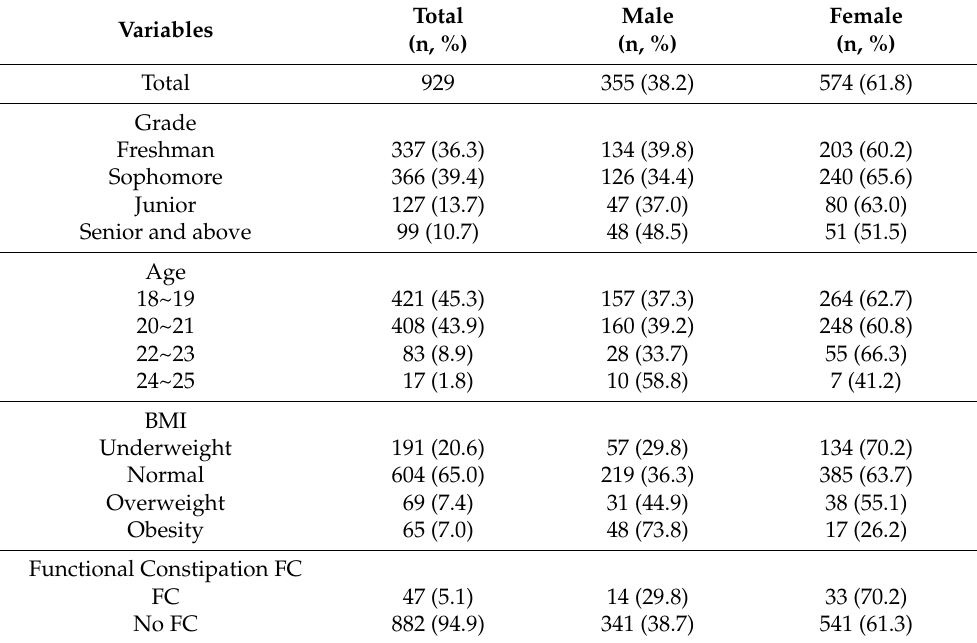
Table 1. Different demographic characteristics of university